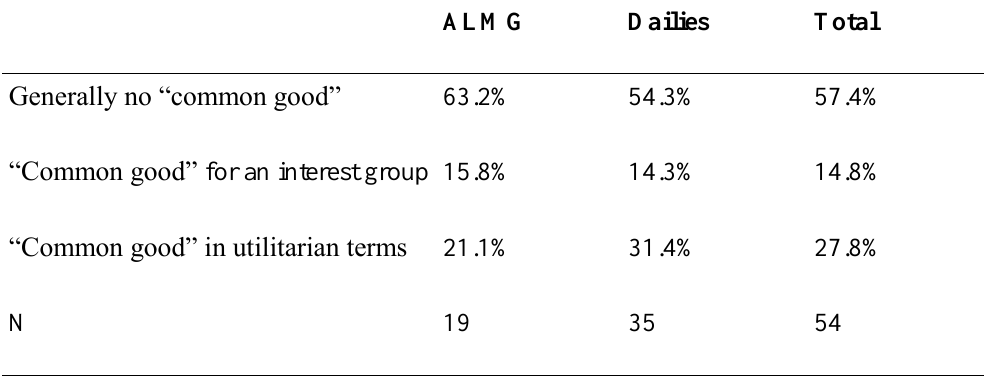
Table 5: Experts’ references to the “common good” in each type of setting ALMG Dailies Generally no “common good” “Common good” for an interest group 15.8%